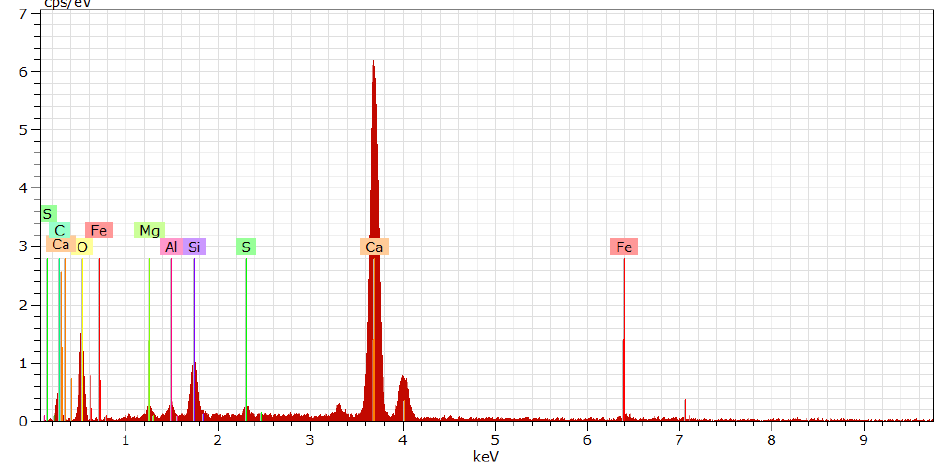
Figure 4. Energy spectrum near hydration product.